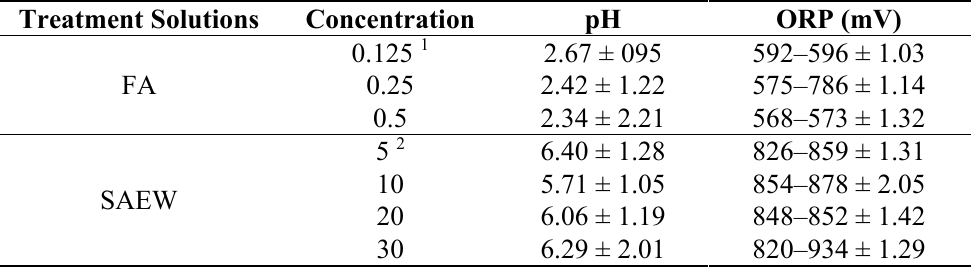
Table 1. pH and oxidation reduction potential values of fumaric acid at different adjusted percentages and slightly acidic electrolyzed water at different adjusted available chlorine concentrations (ACC).